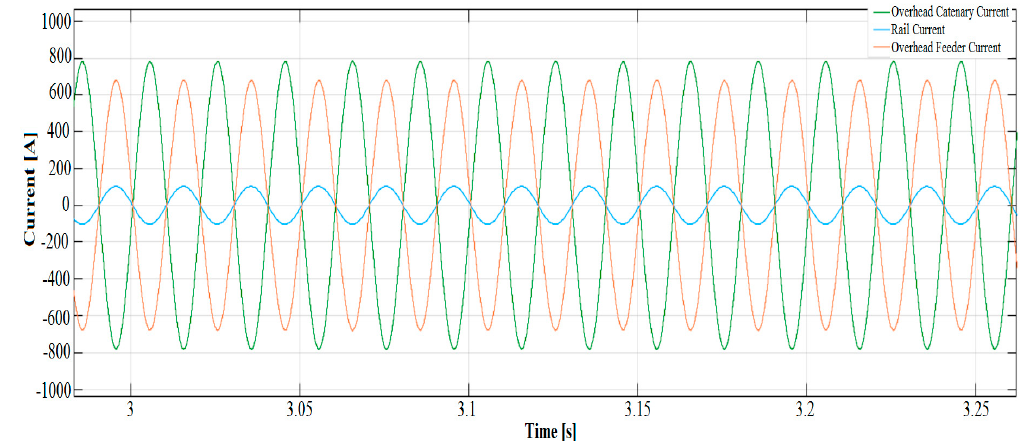
Figure 22. Current drawn by the feeding transformer in the two-train scenario.